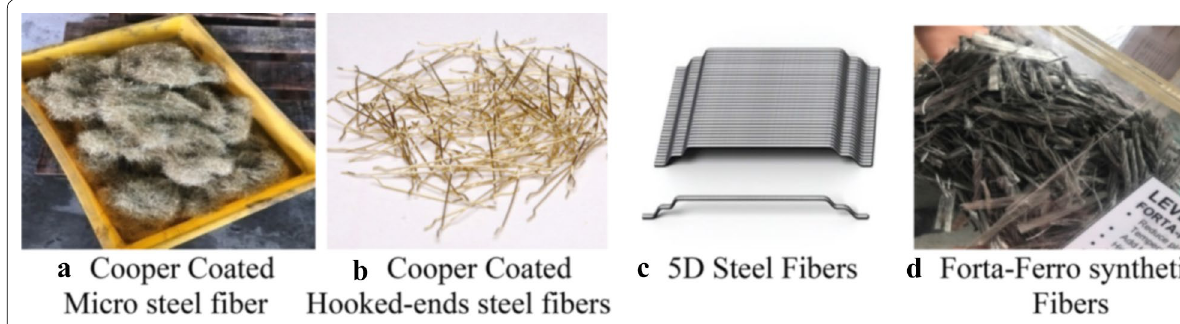
Fig. 2 The considered different types of fibers